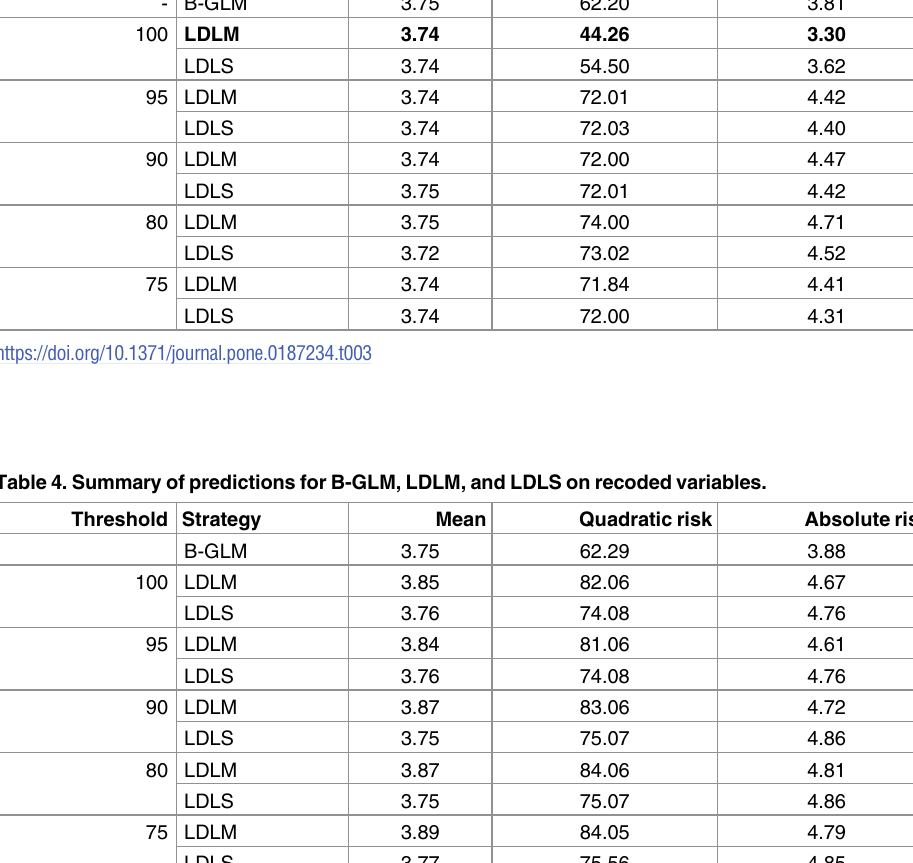
Table 3. Summary of predictions for B-GLM, LDLM, and LDLS on original variables. Threshold Strategy